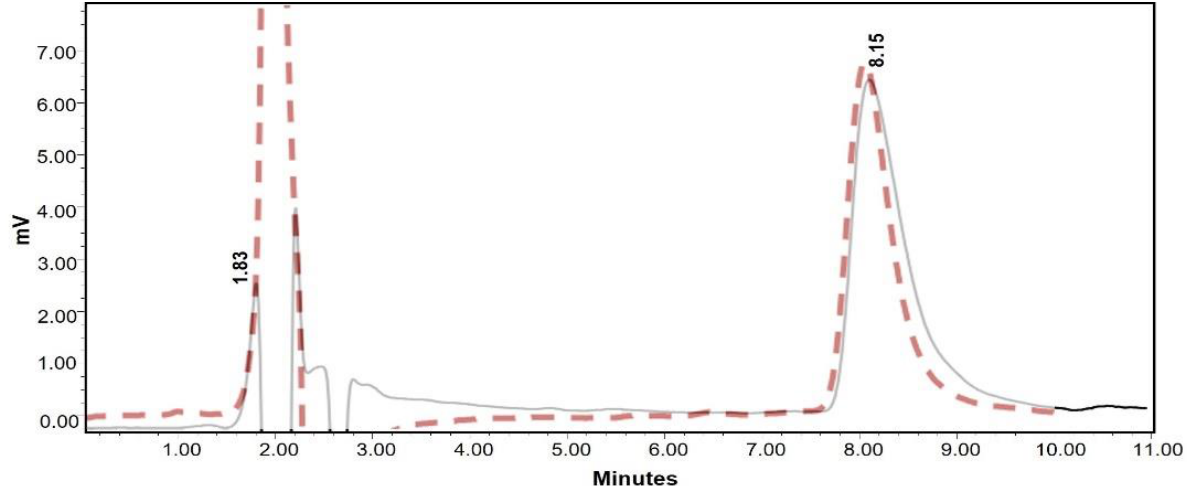
Figure 4. HPLC-PDA chromatogram obtained from the analysis of Argireline peptide solution C ® (red spiked line) superimposed to a chromatogram of a quality control sample of acetyl hexapeptide-8 prepared in water/acetonitrile 30:70, v/v (grey line), both samples contain the analyte at 25 μg mL −1 . Chromatographic conditions: ΒΕΗ ΧBridge ® -HILIC analytical column; mobile phase: 40 mM ammonium formate aqueous solution/acetonitrile (30:70, v/v ), flow rate 0.25 mL min −1 at 214 nm.